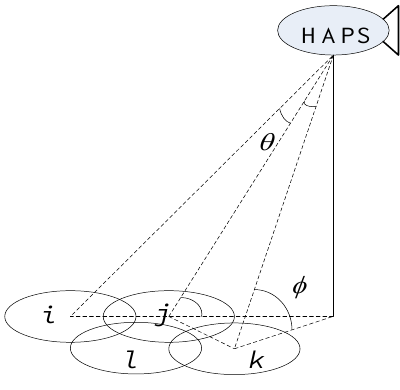
Figure 4. Uplink interference model of HAPS.